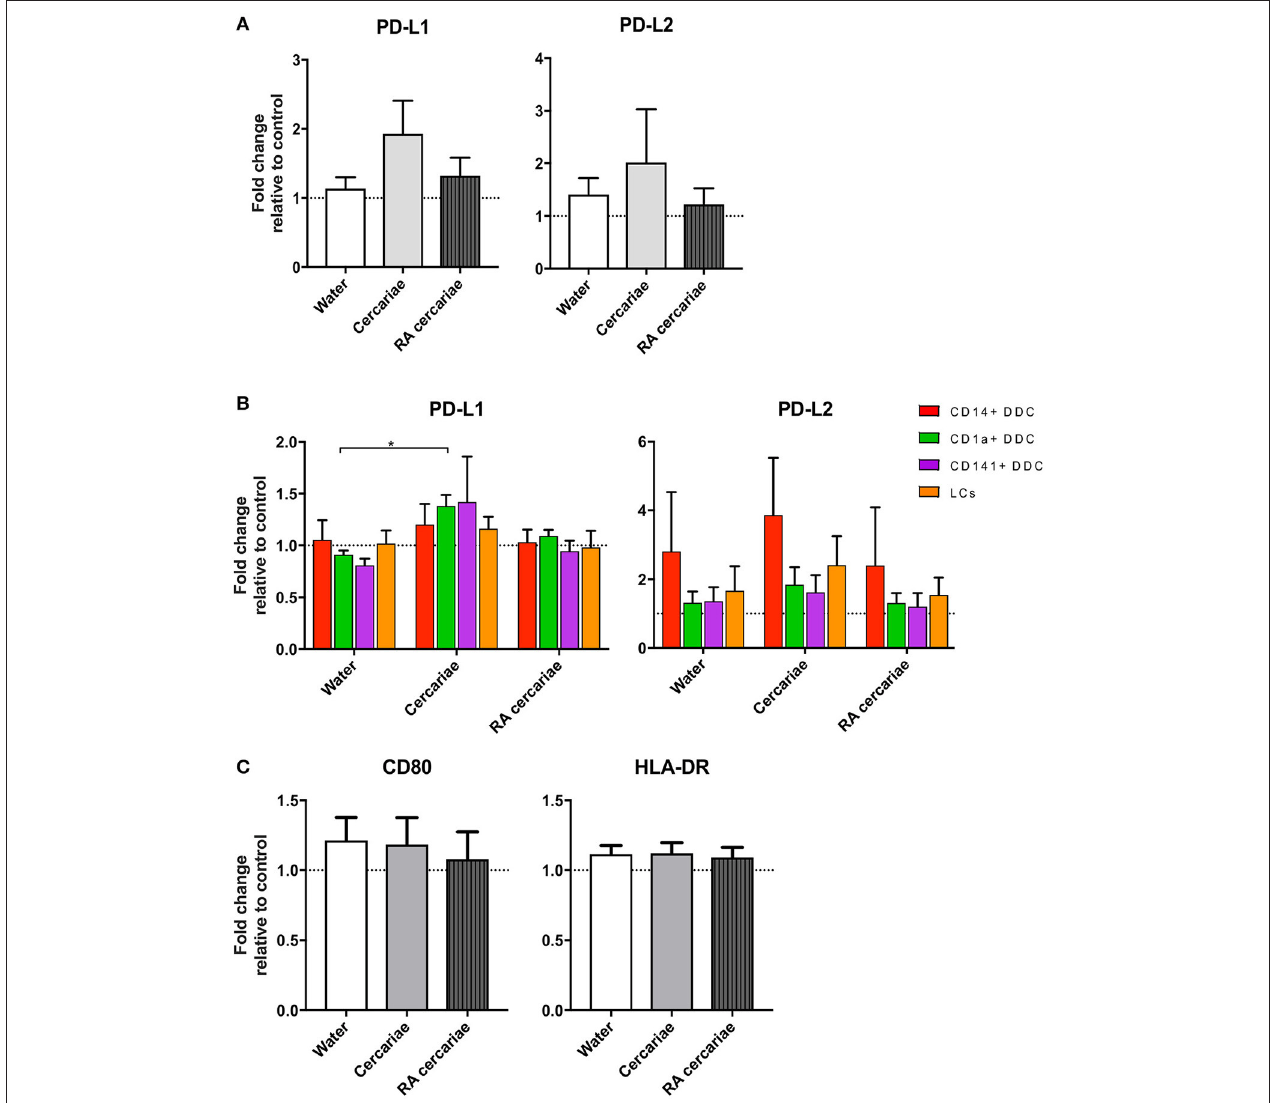
FIGURE 5 | DDCs do not increase activation markers upon cercaria exposure but do show a trend of increased levels of immunoregulatory markers PD-L1 and PD-L2. Immunoregulatory markers PD-L1 and 2 are up regulated in DDCs when exposed to Cercariae but not RA Cercariae ( n = 3) (A) . PD-L1 expression primarily occurs in CD1a + DDCs. ( n = 3) (B) . CD80 and HLA-DR expression in total emigrated HLA-DR + , CD11c + antigen presenting cells from dermal biopsy at 84h post exposure to S. mansoni cercariae or water control ( n = 7) (C) . Mean ± SEM. * p <